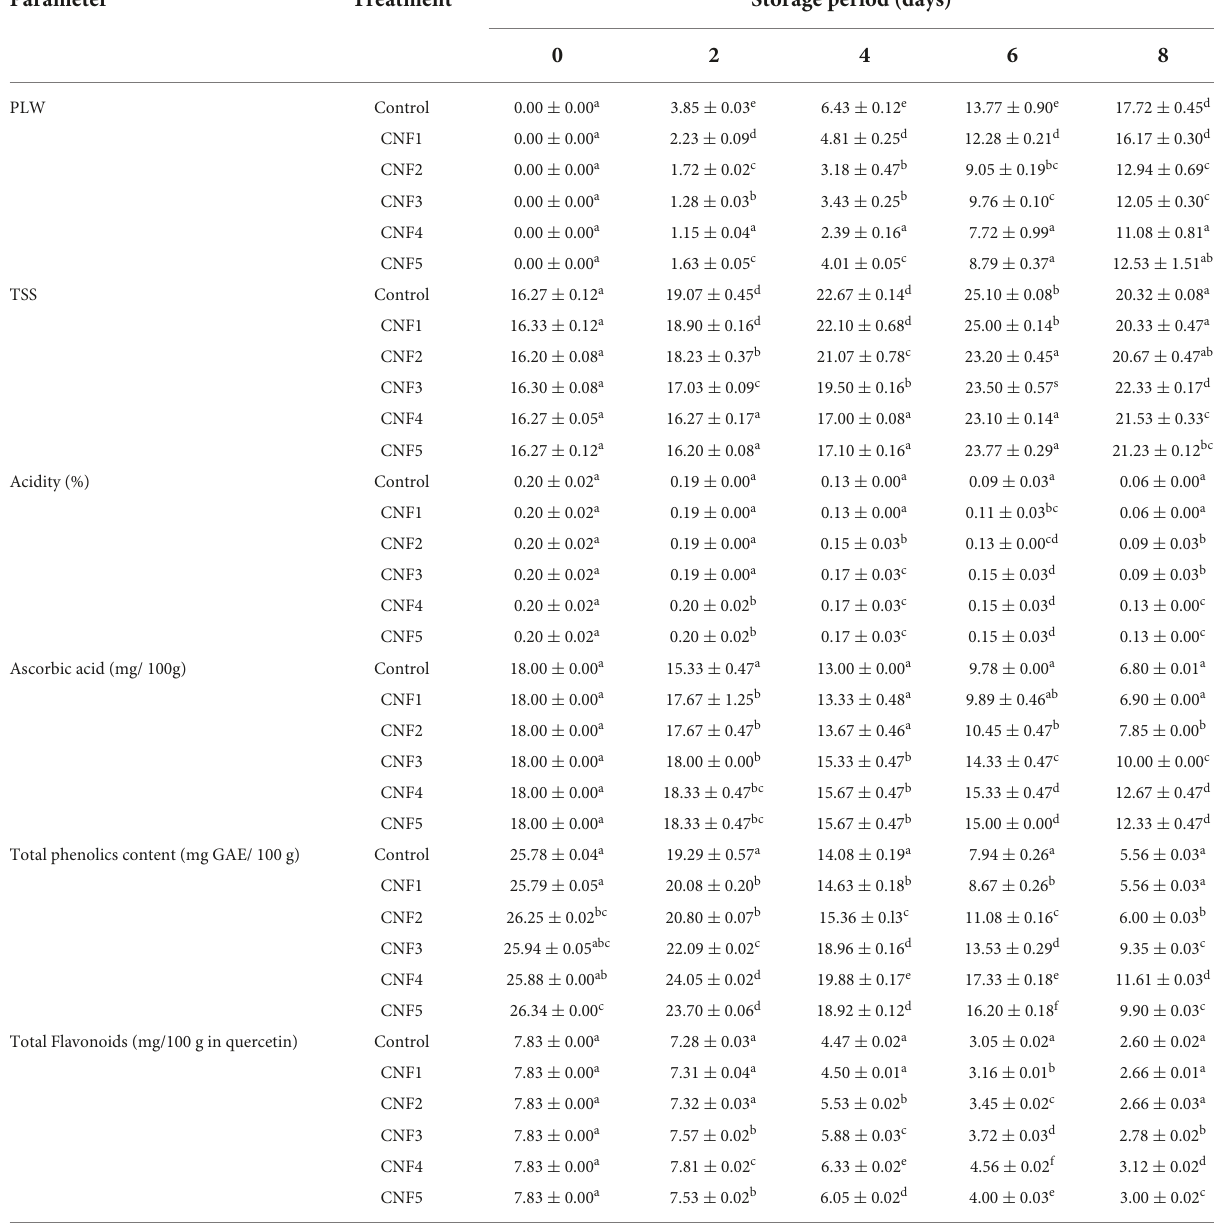
TABLE 3 Effect of in-pack composite nanofibre placement on physicochemical quality of sapota fruits during storage at 26 ± 2 ◦